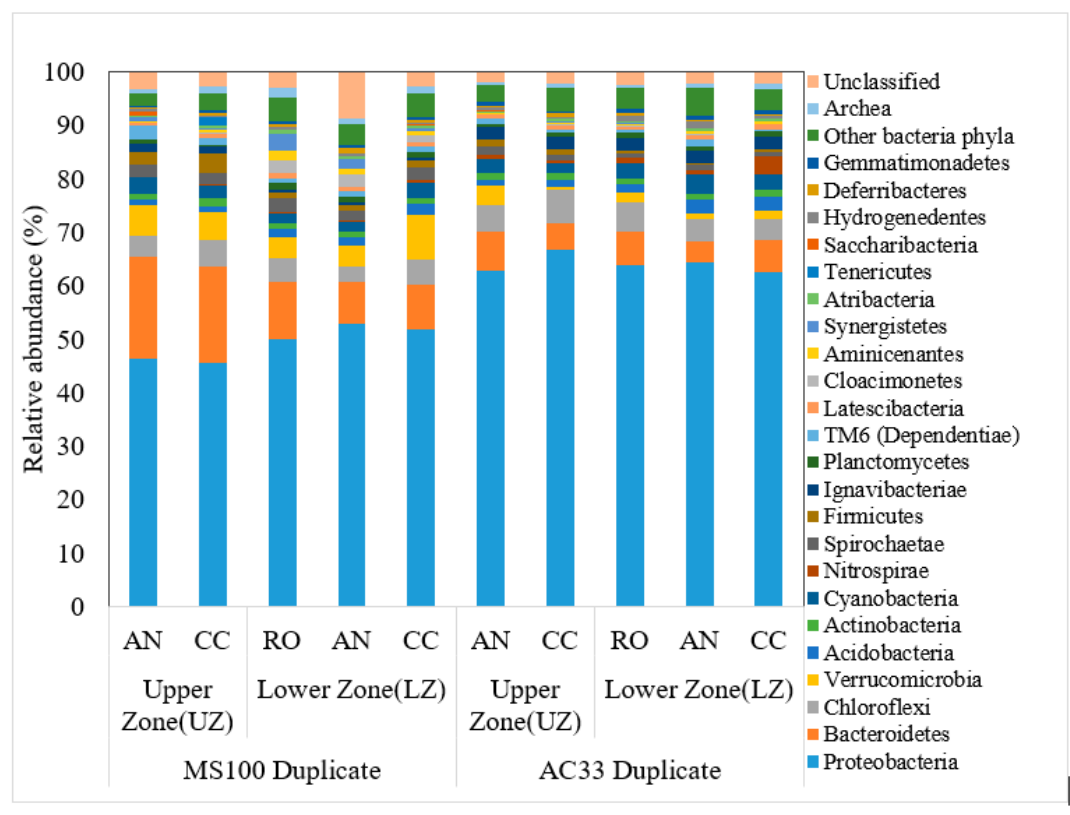
Figure 8. Bacterial and archea phyla.